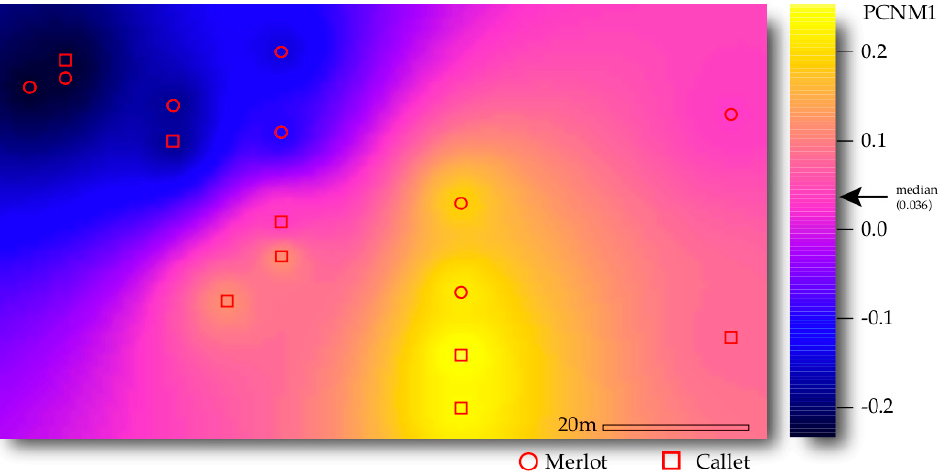
Figure 2. Spatial distribution of the first axis of the principal coordinates of neighbor matrices’ (PCNM) spatial decomposition over the studied plot. The values were interpolated across sampled points. The colored scale indicates the PCNM values.